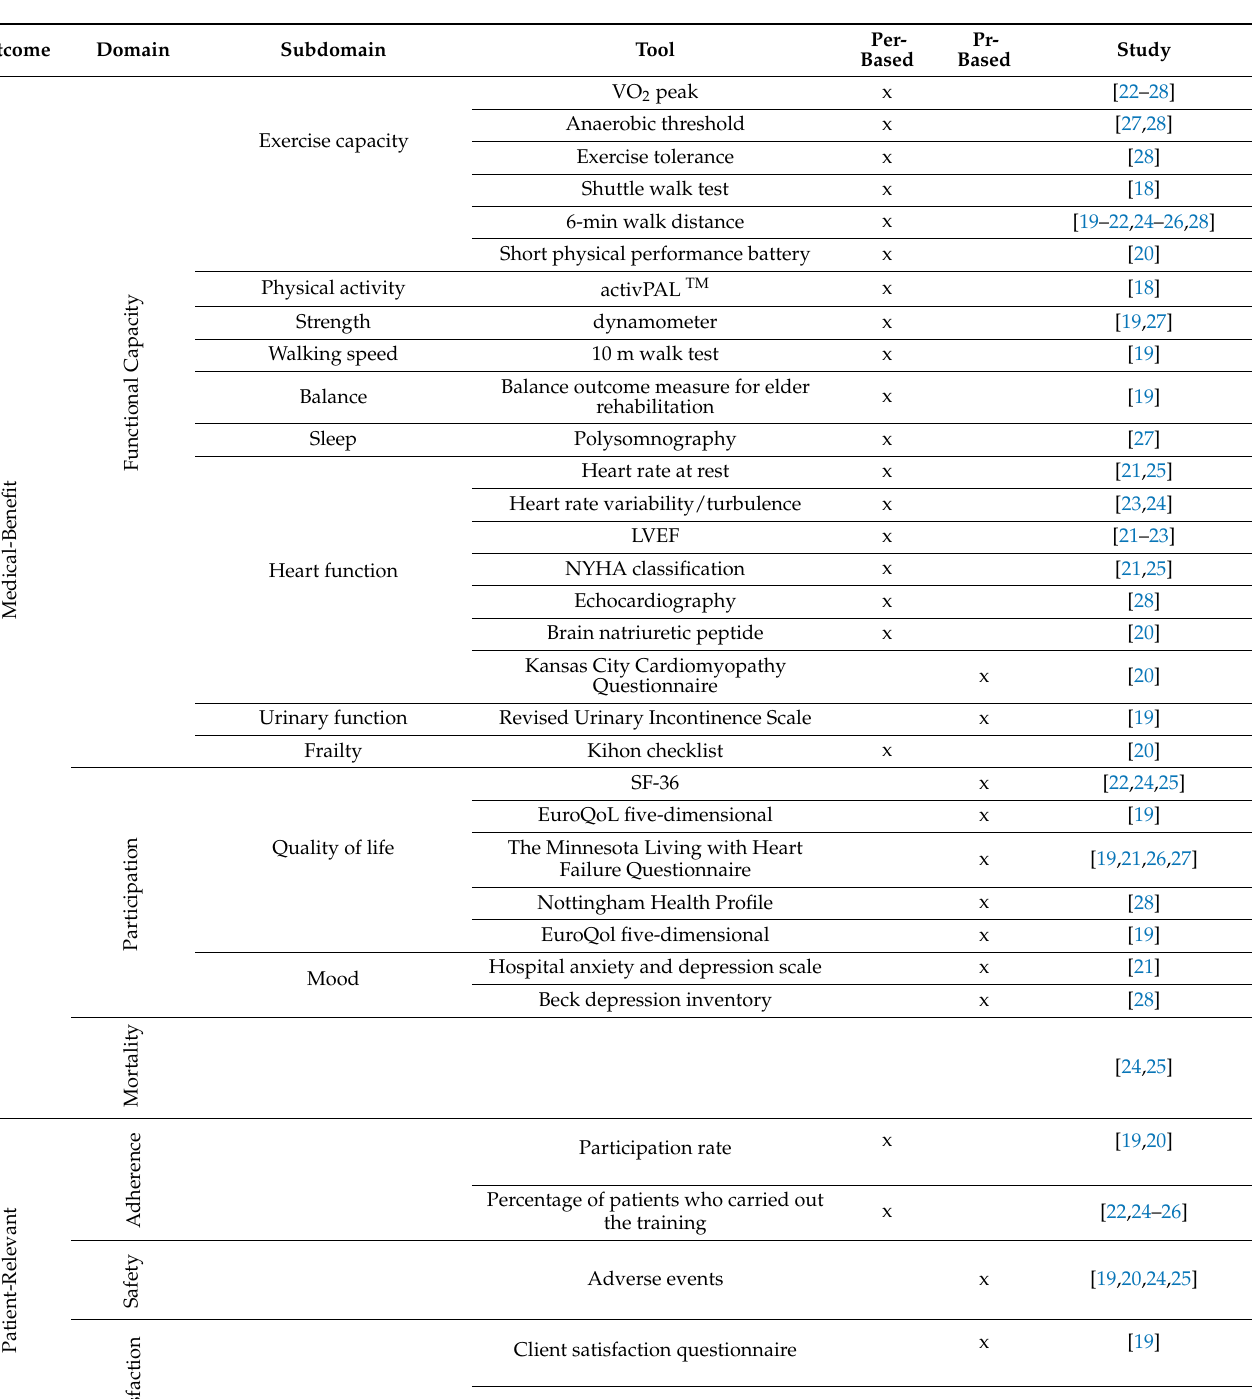
Table 4. Description of the outcome measures of the included studies (n = 11). VO 2 = max oxygen consumption; NYHA = New York Heart Association; PER-BASED = performance-based; PR-BASED = patient-reported